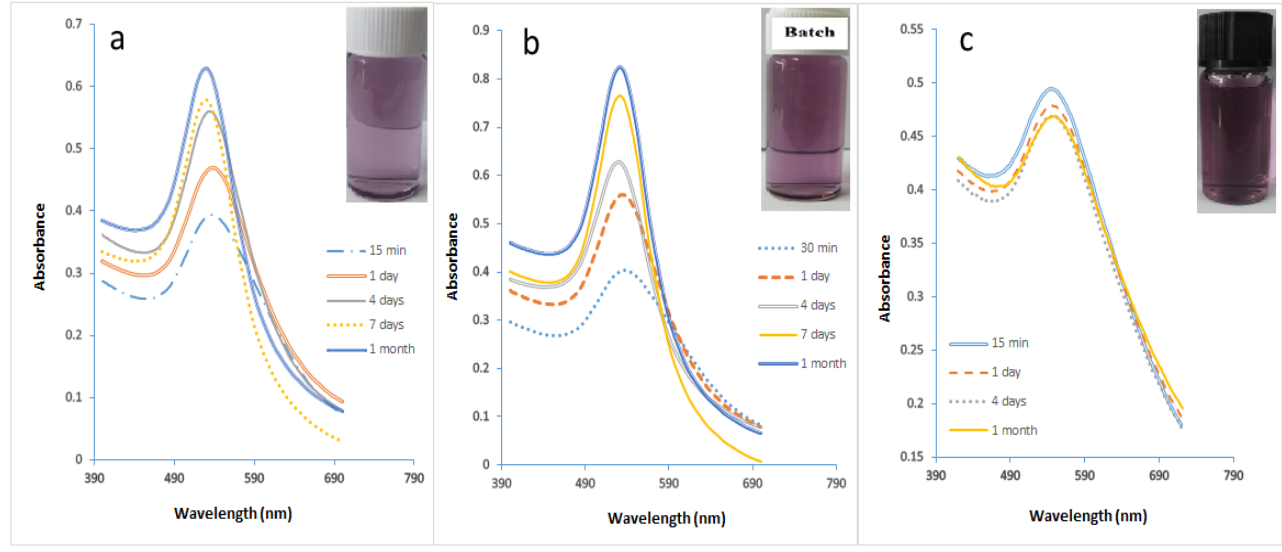
Figure 10. ( a ) The UV spectra of GNPs samples prepared in the presence of PVA in a microreactor at a concentration of HAuCl 4 of 1 mM ( b ) using the batch method. ( c ) using a microreactor with an initial HAuCl4 concentration of 2 Mm. (Cons of SC, SB = 0.1 mM, T = 308.15 K, SB/HAuCl 4 volumetric ratio = 4:10, pH i = 3).